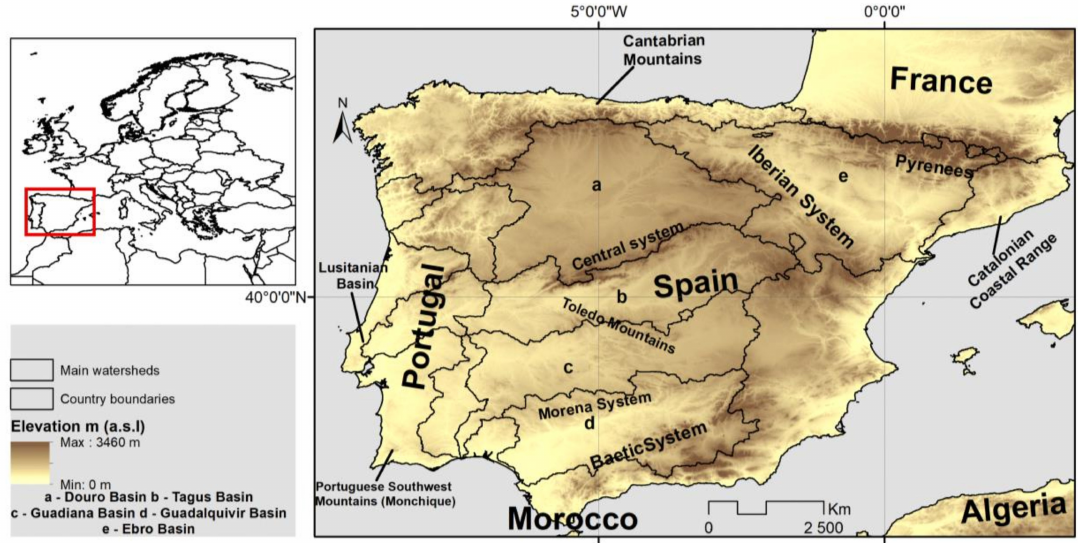
Figure 1. Study area—Iberian Peninsula with major river basins and mountain chains where most phylogeographic refugia are